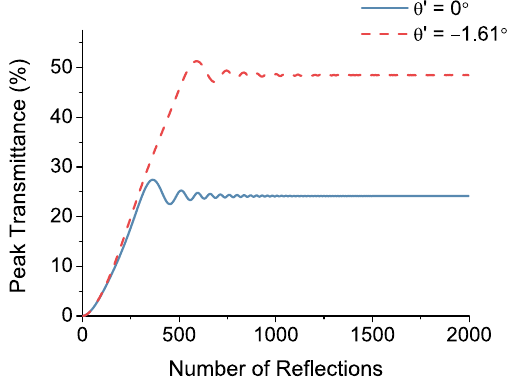
Figure 4. Peak transmittance of the LVOF at 3.3µm wavelength with respect to the number of reflections in the cavity, observed at normal and oblique